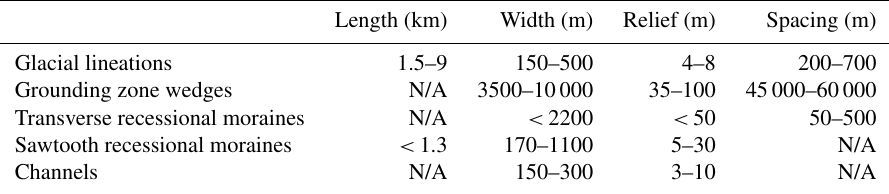
Figure 4. (a) Swath bathymetry map from the middle part of Store Koldewey Trough. The locations of grounding zone wedges A–D are indicated in the inset map (bathymetry from IBCAO v.4.0; Jakobsson et al., 2020). (b) Interpretation and distribution of landforms. Table 3. Dimensions of submarine